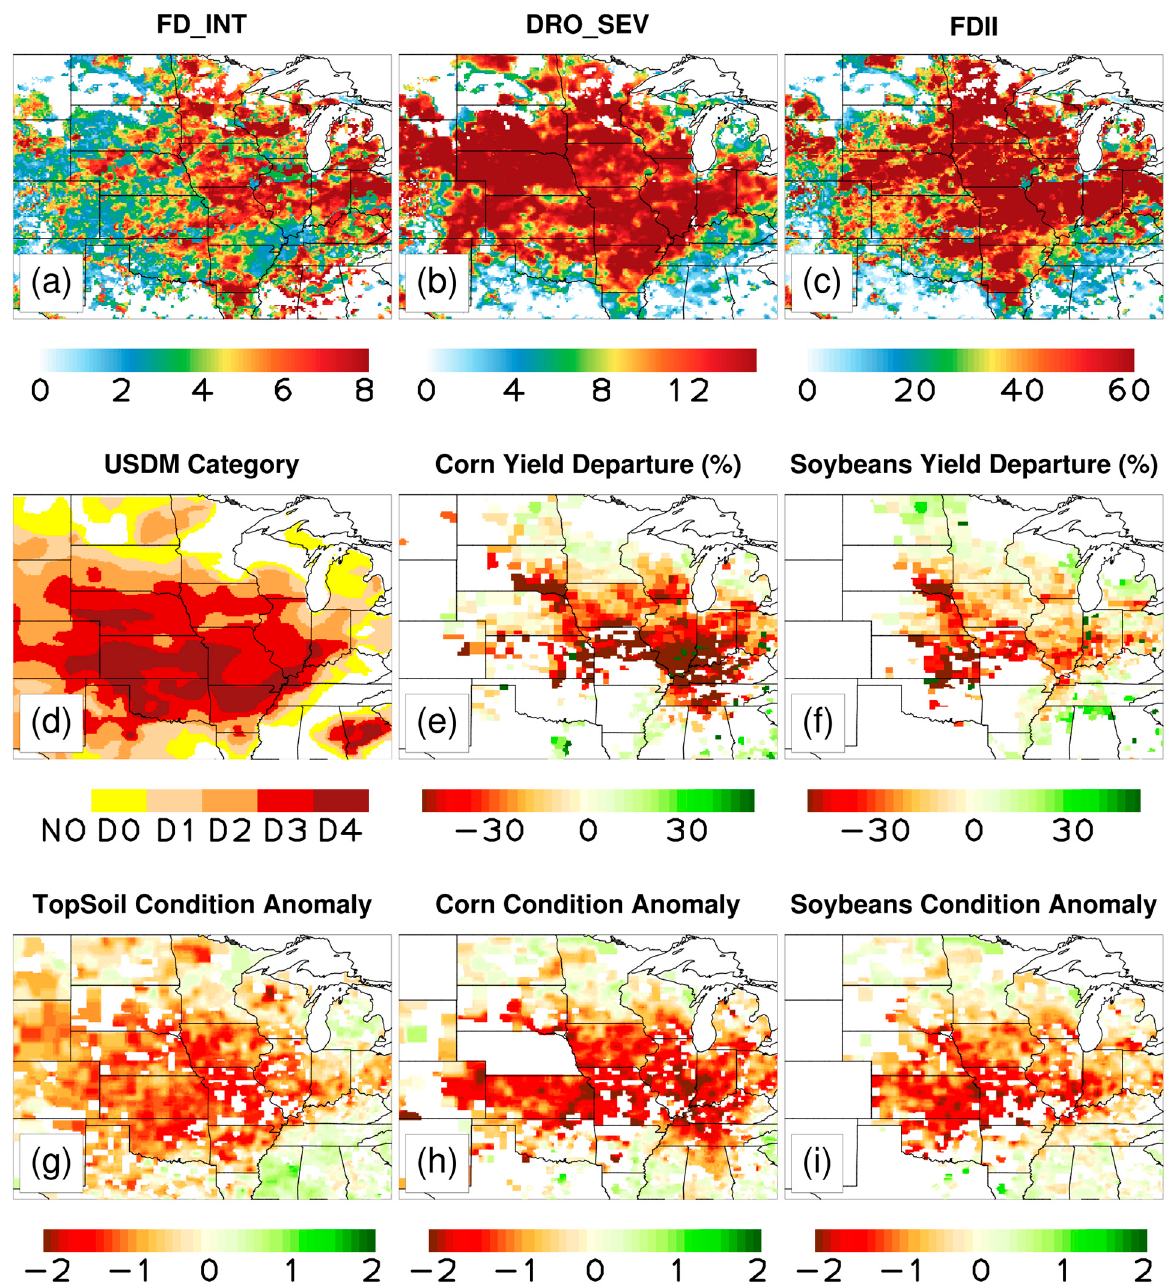
Figure 5. Maximum ( a ) FD_INT, ( b ) DRO_SEV, and ( c ) FDII values for each grid point between 1 May and 18 August 2012. ( d ) USDM drought analysis on 18 August 2012. Trend-adjusted yield departures (%) for 2012 for ( e ) corn and ( f ) soybeans. Anomalies in NASS ( g ) topsoil moisture, ( h ) corn, and ( i ) soybean conditions on 18 August 2012.